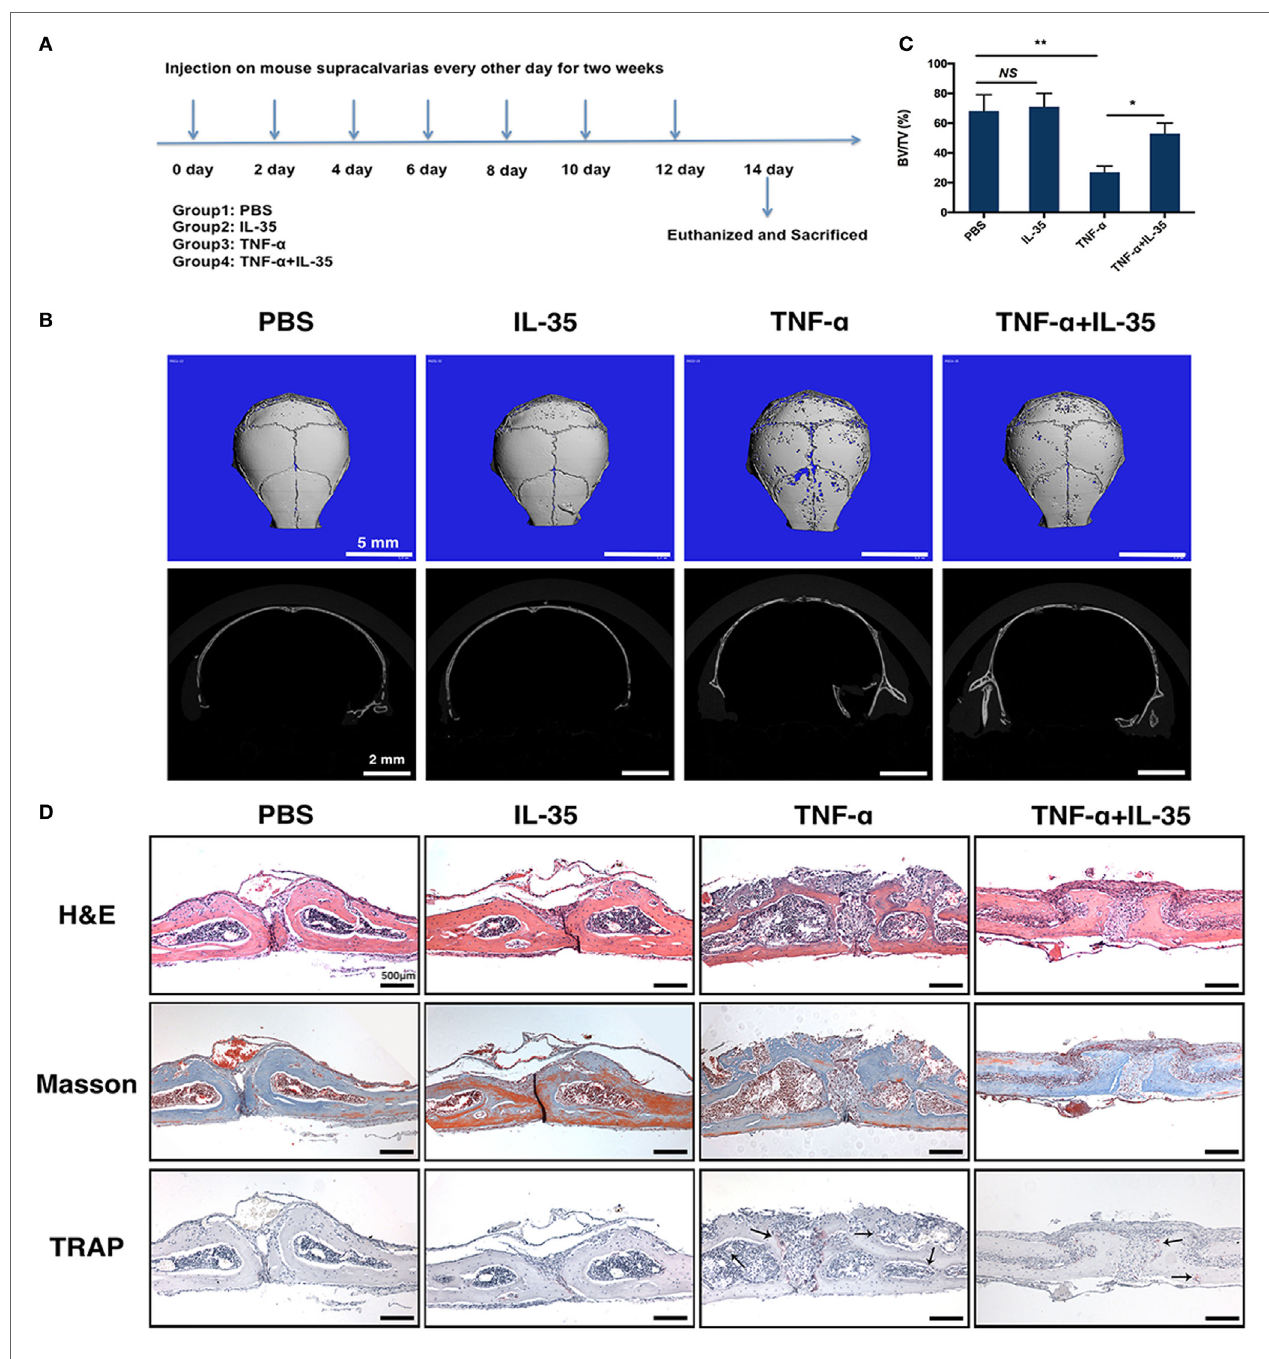
FigUre 6 | TNF- α -induced calvarias osteolysis model was established to investigate the effect of Interleukin 35 (IL-35) in vivo . (a) Timeline of animal experiments and group design. (B) Micro-CT analysis of calvarias injected with PBS, IL-35, TNF- α , or IL-35 and TNF- α . (c) Bone volume/total volume (BV/TV) were calculated and analyzed. (D) Hematoxylin and eosin, masson trichrome, and tartrate-resistant acid phosphatase staining of the tissue section. * p < 0.05, ** p <